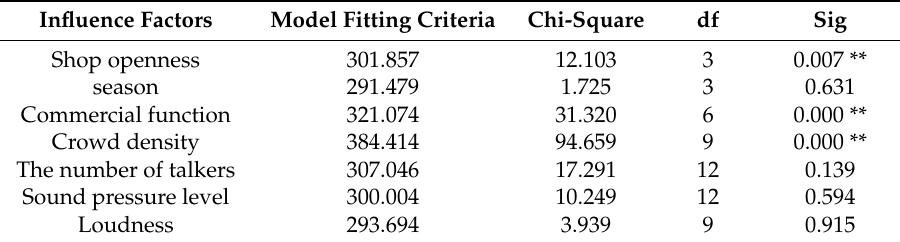
Table 7. The relationship between acoustic comfort and influence